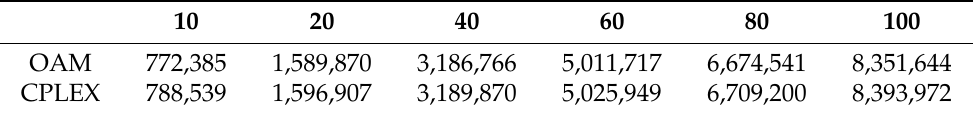
Figure 1. Calculation time comparison of OAM and CPLEX. Table 3. Total operation cost comparison of OAM and